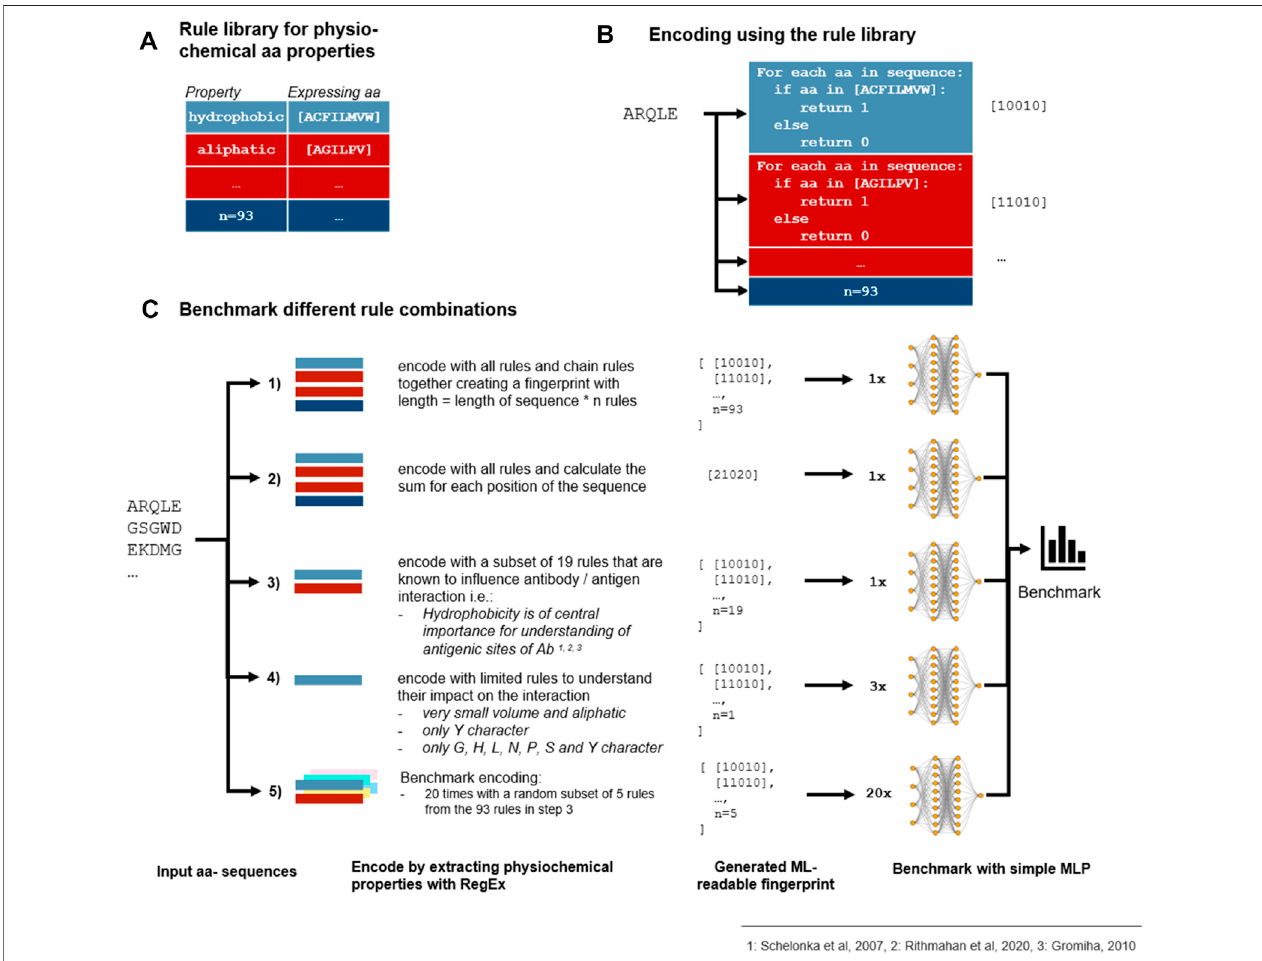
FIGURE1| Benchmarkofencodingwithdifferentphysicochemicalrules. (A) 93ruleswerede fi nedthatdescribethephysicochemicalpropertiesofanAbwhichare expressedasdifferentaminoacidsinaCDR3sequence. (B) Eachruleisrepresentedby1 ’ sand0 ’ swhichareextractedfromtheCDR3a.a.sequencebyusingaregular expression (RegEx). (C) As the rules can be combined differently, we benchmarked different encoding methods which all depend on the rule library to fi nd the best combination of rules. First, every numeric representation of the rules is chained together (Goodwin et al., 2016) or the sum for each a.a. position is calculated (Widrich et al., 2020). Second, as some rules are repeated because some properties are expressed in the same manner and some physicochemical properties are knowntoin fl uencetheantibody – antigeninteractionmorethanothers,asubsetof19ruleswasselected(Akbaretal.,2021).Additionally,arandomlyselectedsubsetof5 rules out ofthe19rules from step 3wascombined with3 rulesto analyze thecontributionofsingle propertiestothe prediction results. As shown inthe fi vefoldvalidated benchmark, chaining of the selected subset outperforms chaining and summing of all rules. As no subset of fi ve rules was able to contend with more extensive encodings, we come to the conclusion that not a few single properties but the combination of various properties is accountable for proper sequence classi fi cation.